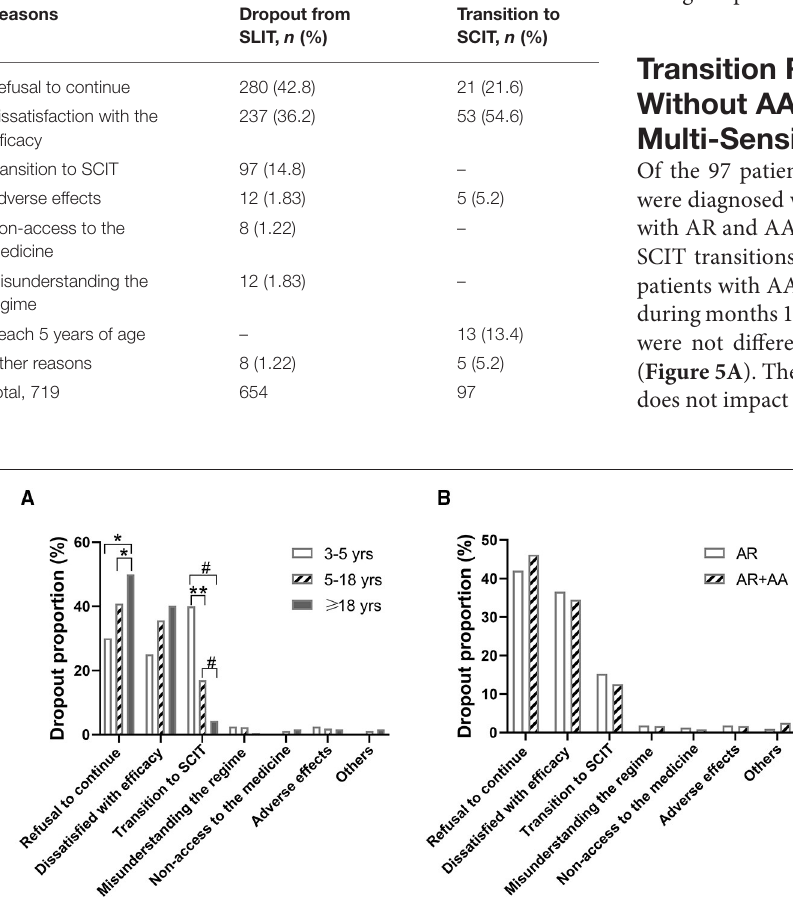
Frontiers in Allergy |